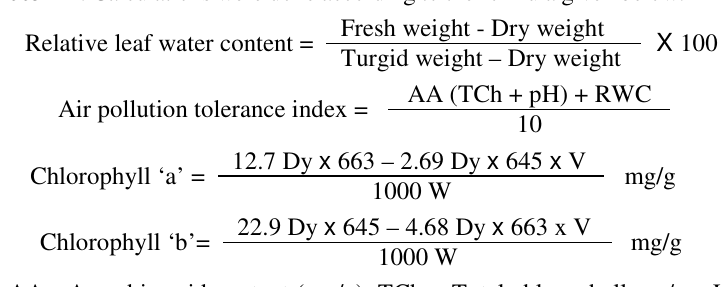
Table 1. Showing the tree species growing in three different stations S.